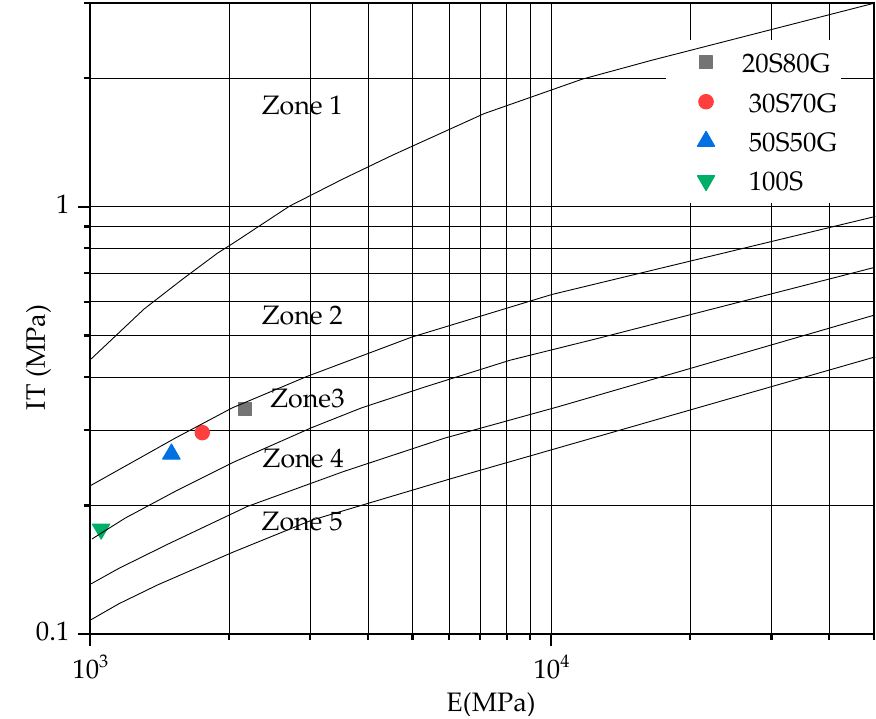
Figure 7. Mix mechanical strength development.